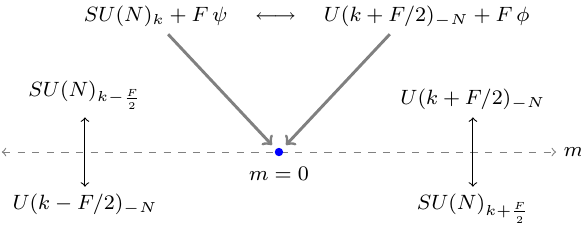
Fig. 1 Phase diagram of SU ( N ) k + F ψ with k ≥ F / 2